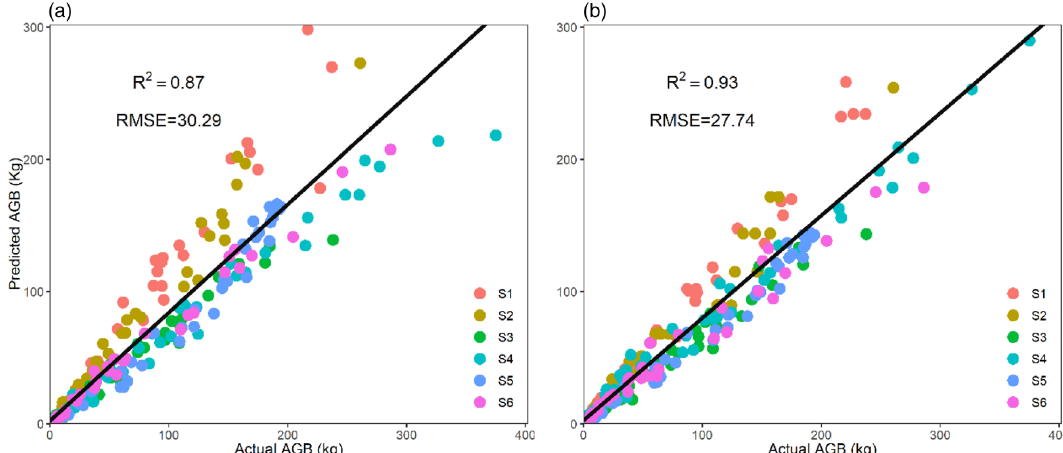
Figure 6. The validation effect of the actual aboveground biomass and the predicted aboveground biomass. ( a ) The predicted biomass estimated by model LnW = a + b*Ln(D). ( b ) The predicted biomass estimated by model LnW = a + b*Ln(D 2 H). S1–S6 represented the six sampling sites for 249 actual biomass data. RMSE indicates root mean square error; R 2 indicates R